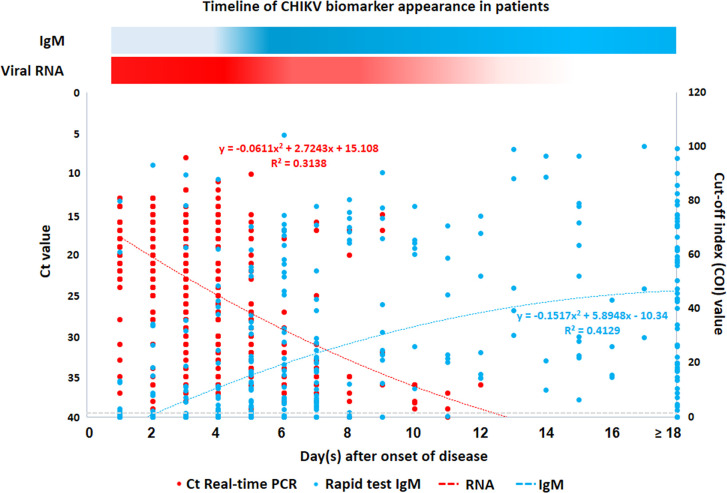
Detection of CHIKV RNA by real-time RT-PCR and IgM antibody specific to CHIKV antigen by rapid test.Results of 1,295 CHIKV infected patients were shown. Samples were tested by both real-time RT-PCR and rapid test for IgM antibody as described in the Materials and Methods. The Ct value and cut-off index (COI) represent the results of real-time RT-PCR and rapid IgM tests, respectively. COI is based on the ratio of assay signal to cut-off value of which COI≥1 = positive for anti-CHIKV IgM antibody and COI <1 = negative for anti-CHIKV IgM antibody. Curve equations and determination coefficients (R2) are indicated.